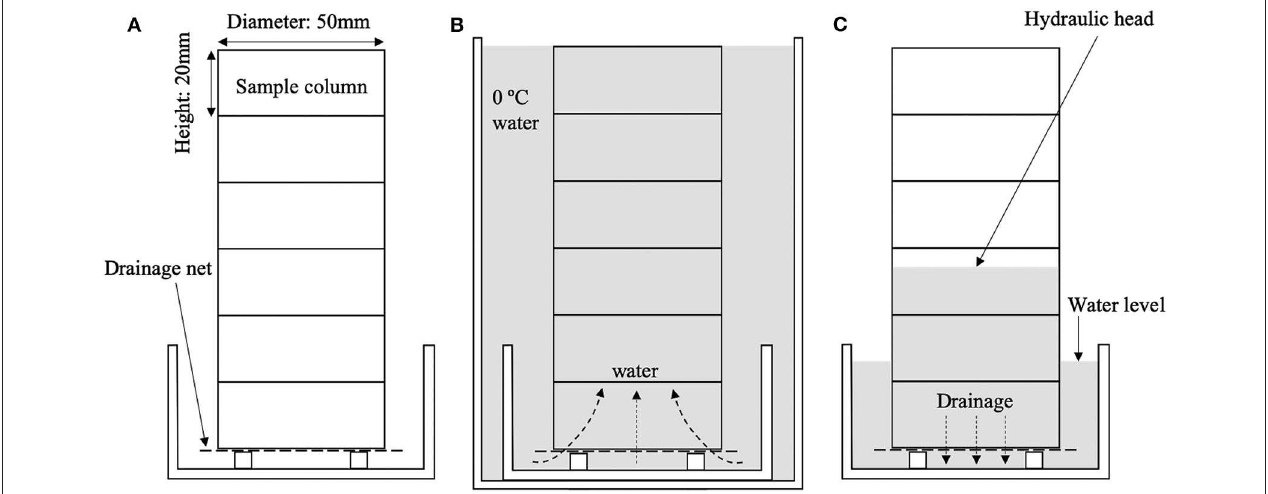
FIGURE 4 | Schematic diagram of measurement of the water retention curve of snow. (A) Initial state of sample column with dry snow. (B) The column submerged in water until the saturated condition. Water could go in the column only from the bottom. (C) The column settled in the low temperature room until the steady state of movement of water.